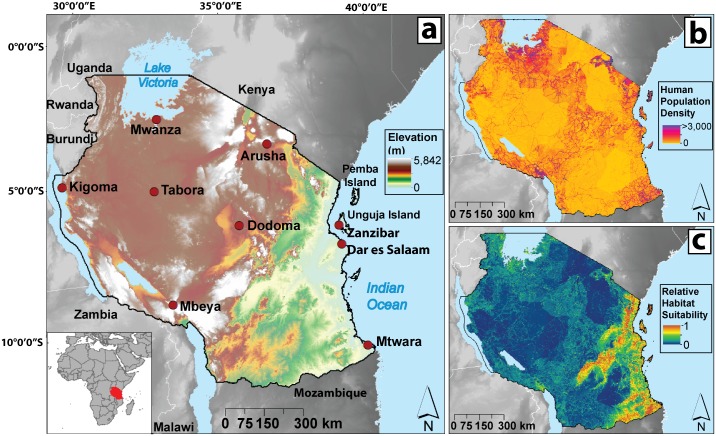
Map of the United Republic of Tanzania, human population density map, and Anopheles habitat suitability map.The figure shows (A) an elevation map with major cities of Tanzania and neighbouring countries. The inset map details Tanzania’s location in eastern Africa. (B) Map of human population density from LandScan (http://web.ornl.gov/sci/landscan/) with ~1 km2 (30 arc second) resolution. (C) The Maxent output map of relative Anopheles mosquito habitat suitability. The map ranges from blue to red representing low to high habitat suitability, respectively.